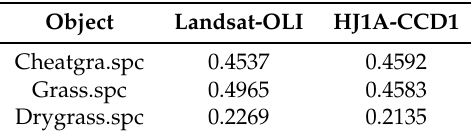
Table 3. The Comprehensive Production Suitability Index (CPSI) of Cheatgra.spc, Grass.spc and Drygrass.spc.